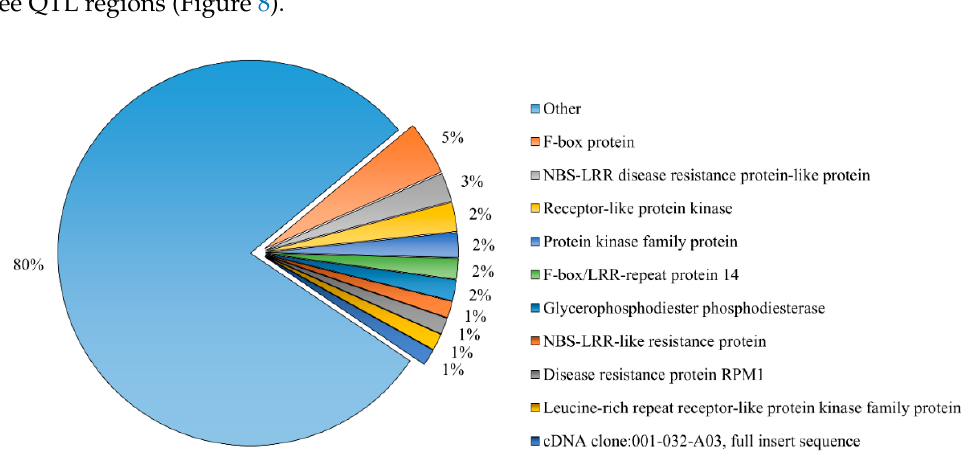
Figure 8. Pie chart demonstrating the over-represented DEGs that were localized in 1BS, 2BL and 3DL QTL regions.